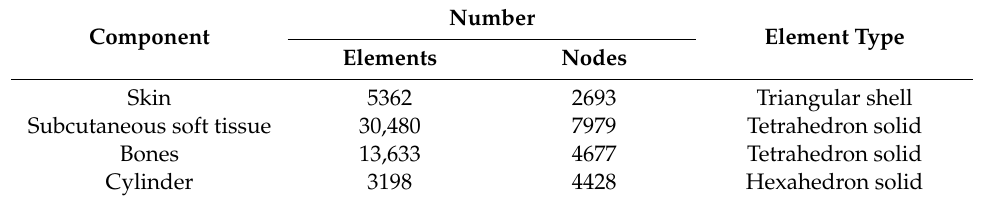
Figure 2. Hand FE model and cylinder FE model. Table 1. Number of elements and nodes as well as type of element used in the hand FE model and cylinder FE model.